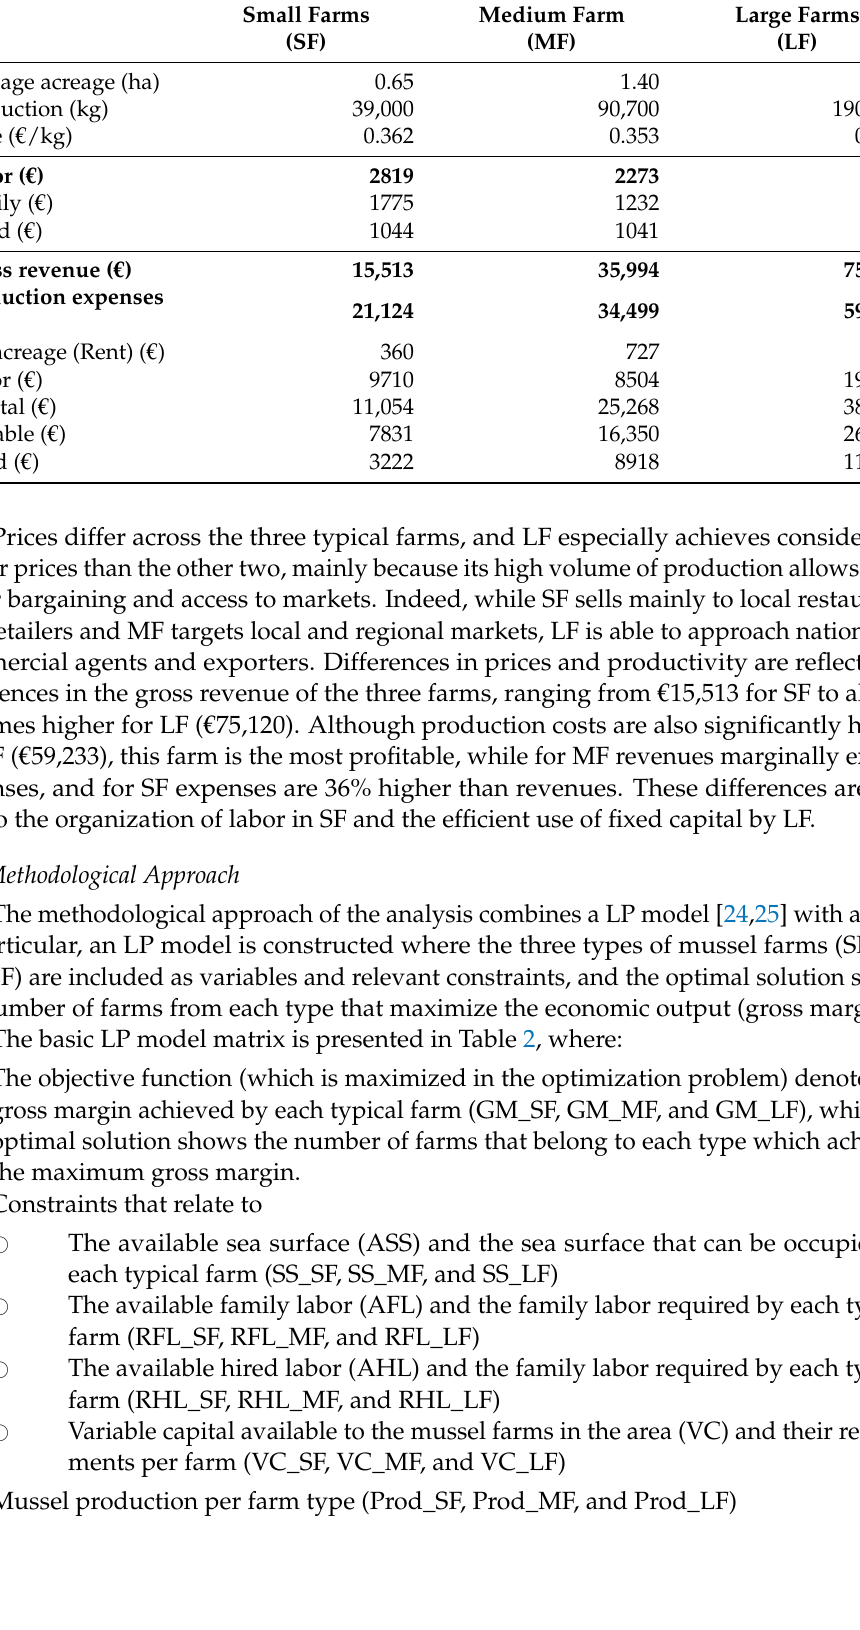
Table 1. Technical and economic indicators of typical mussel